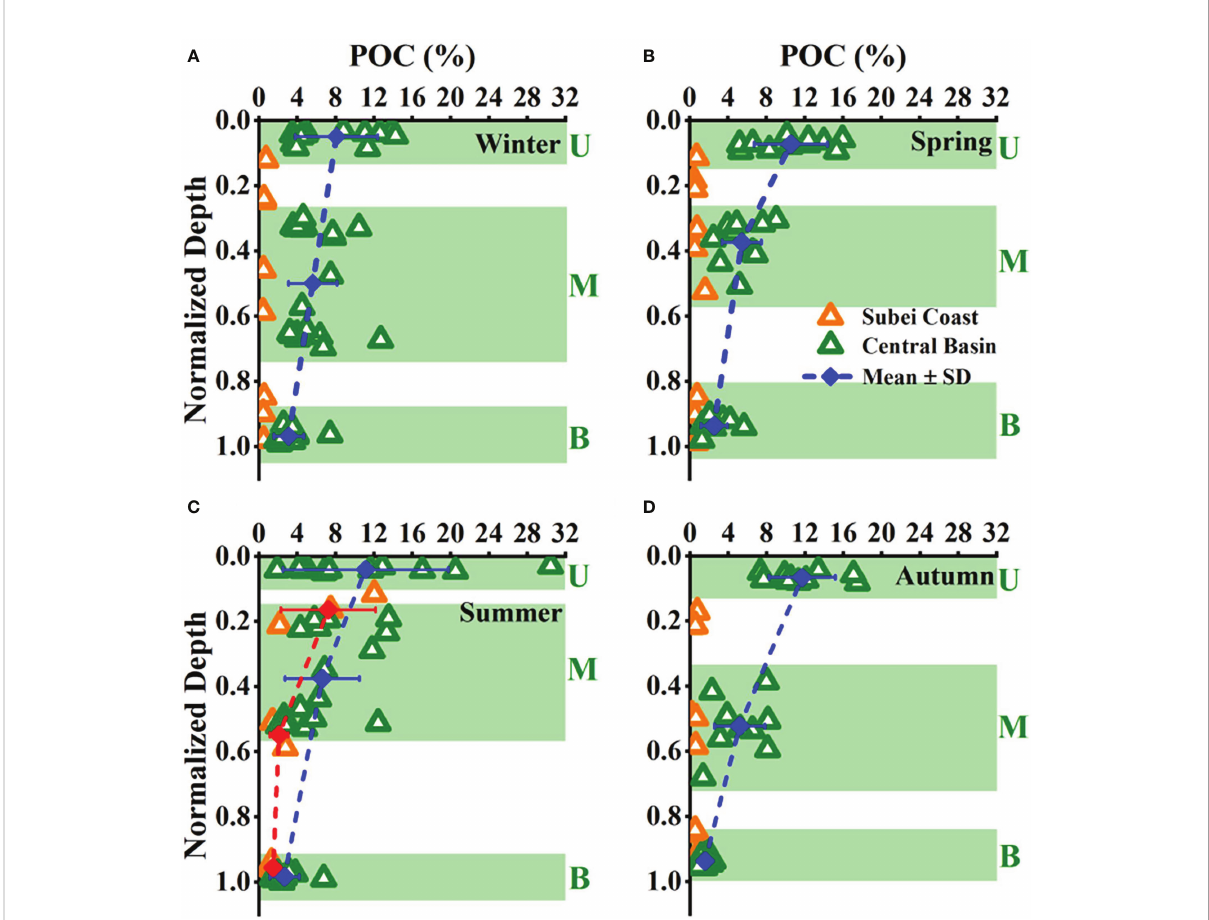
FIGURE 7 Vertical patterns of percentage content of particulate organic carbon (POC%) in the total suspended matters with normalized depth among seasons (A – D) . Triangles with different colors represent different areas (orange, Subei coast; olive, central basin). The vertical distribution in the central basin showed a three-layer structure, as marked by the light green frames. U, upper layer; M, middle layer; B, bottom layer. Blue points connected by a dashed line show the change of the mean values in each layer of the central basin. Red points connected by a dashed line in panel C show the change of the mean values in each layer of the Subei coast region during